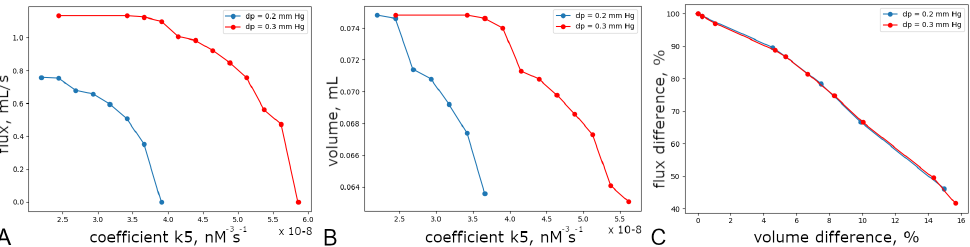
Figure 10. Dependence of the total flux through the network ( A ) and volume network ( B ) on the kinetic constant k 5 for different pressure gradients. Flux–volume dependence ( C ) is close to linear, and it does not depend on pressure